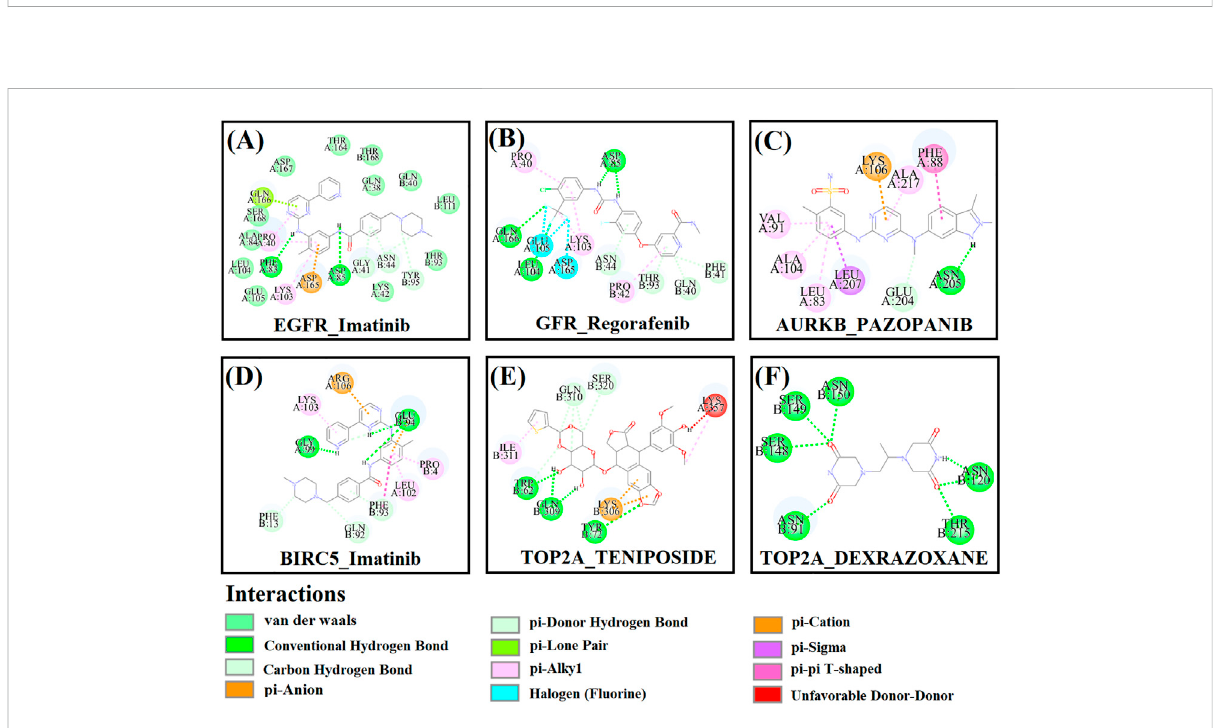
FIGURE 9 Two-dimensional (2D) structures between receptor proteins and candidate drugs and highlighting interaction types. (A) EGFR – imatinib, (B) EGFR – regorafenib, (C) AURKB – pazopanib, (D) BIRC5 – imatinib, (E) TOP2A – teniposide, and (F) TOP2A – dexrazoxane.